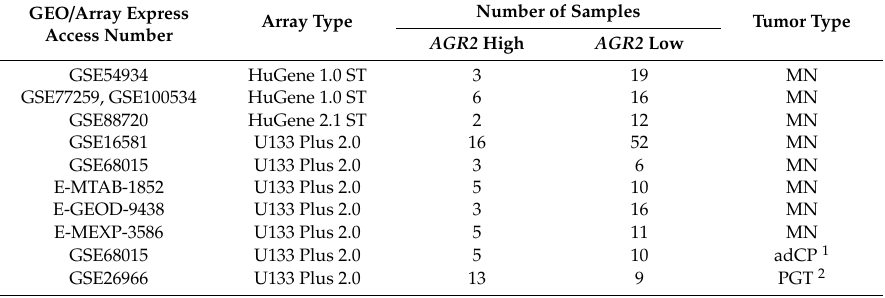
Table 1. Microarray expression studies included to investigate di ff erentially expressed genes in high AGR2 expression tumors versus low AGR2 expression